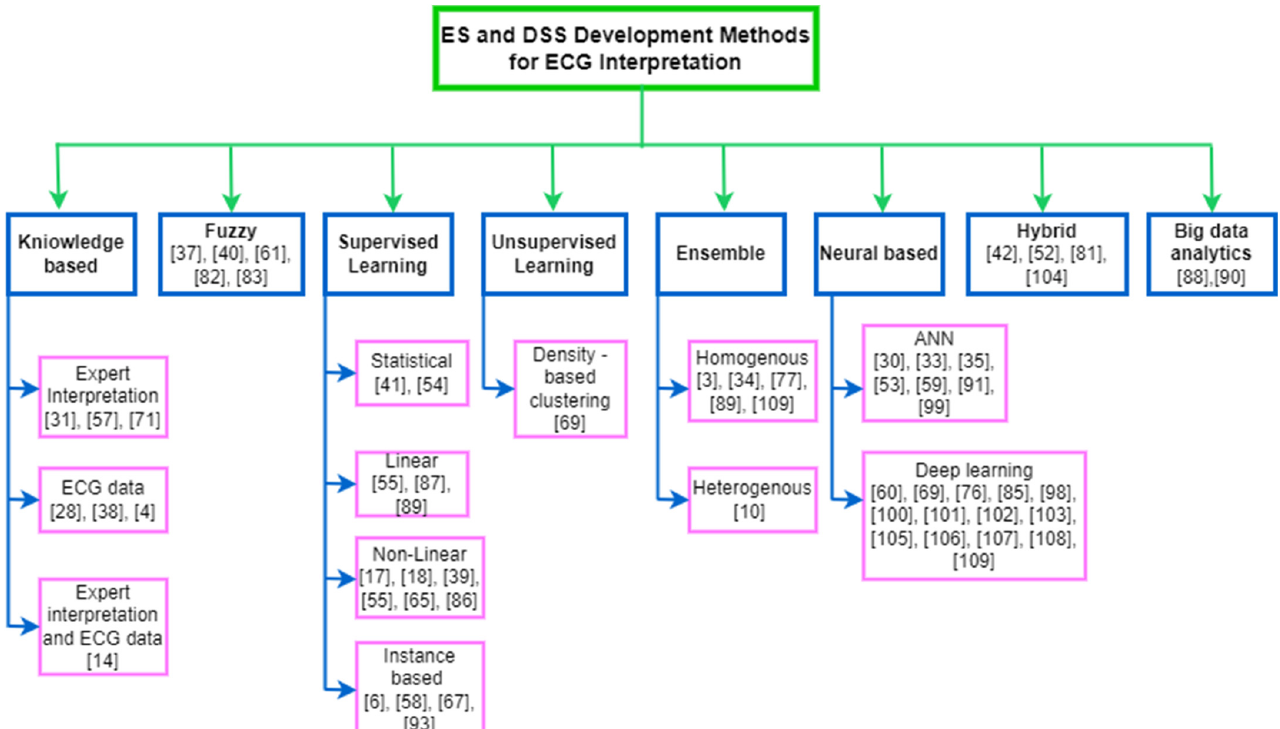
Figure 10. Taxonomy of methods for ES/DSS development in ECG interpretation .